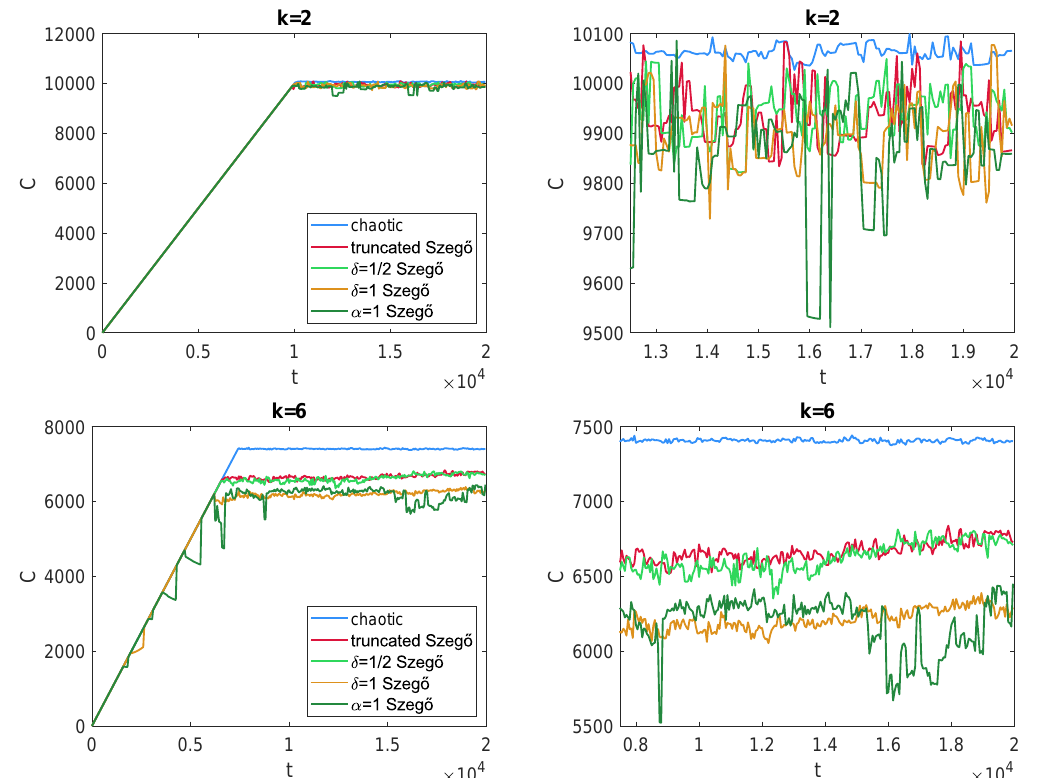
Figure 7: A comparison of the time evolution of the bound on complexity (3.17) at N = M = 30, where D = 5604, and locality threshold k = 2 for the top and k = 6 for the bottom figures, for five systems that display different degrees of